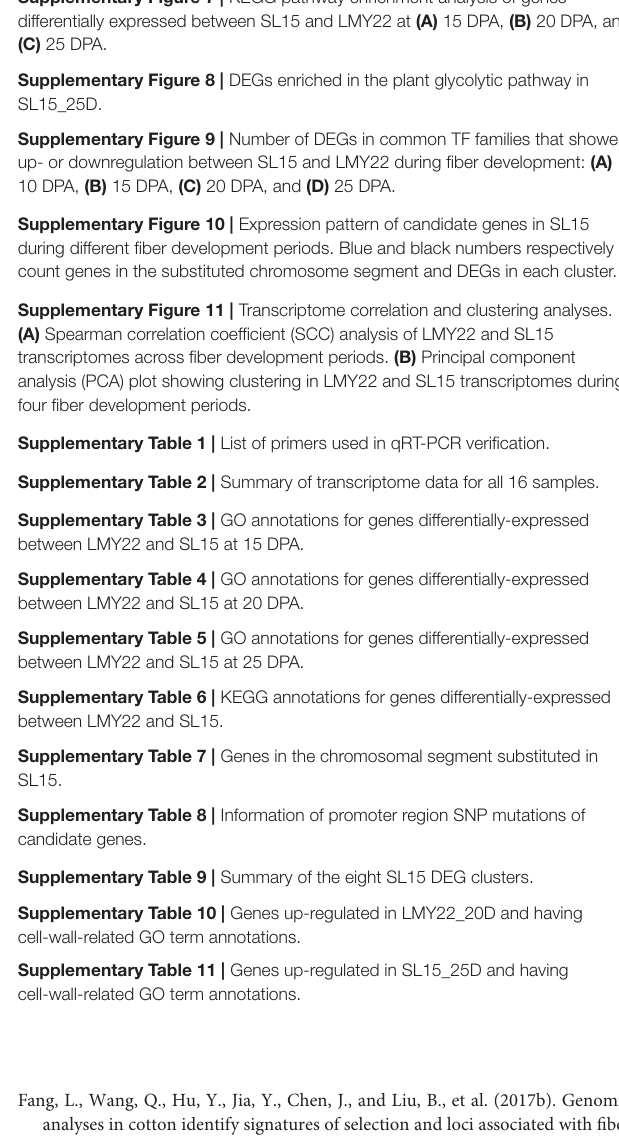
Supplementary Figure 6 | GO term enrichment analysis of genes differentially expressed between SL15 and LMY22 at (A) 15 DPA, (B) 20 DPA, and (C) 25 DPA. Supplementary Figure 7 | KEGG pathway enrichment analysis of genes differentially expressed between SL15 and LMY22 at (A) 15 DPA, (B) 20 DPA, and (C) 25 DPA. Supplementary Figure 8 | DEGs enriched in the plant glycolytic pathway in SL15_25D. Supplementary Figure 9 | Number of DEGs in common TF families that showed up- or downregulation between SL15 and LMY22 during fiber development: (A)